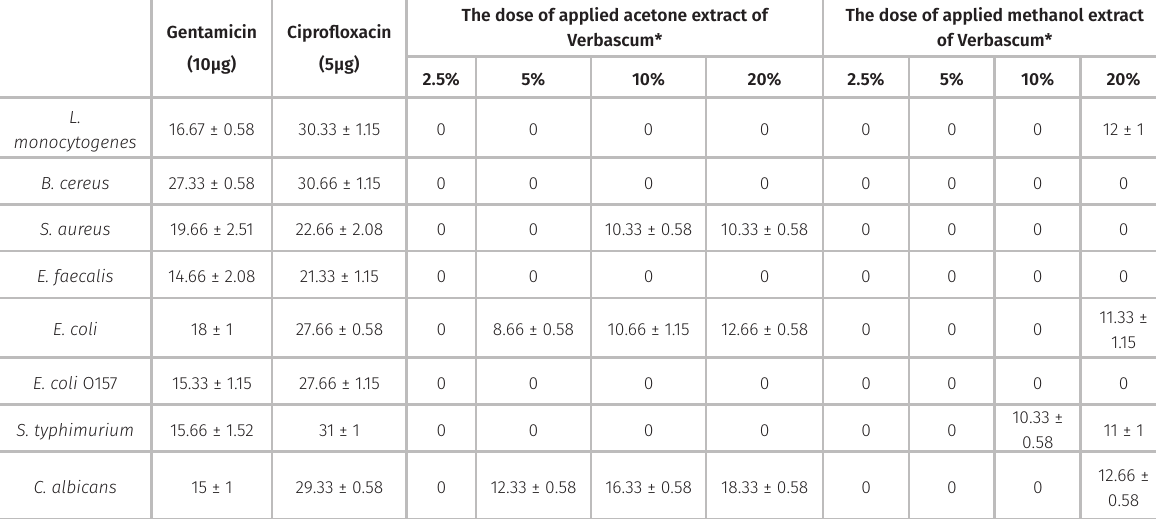
Table IV. Antibacterial activity of Verbascum lasianthum Boiss. ex Benth.